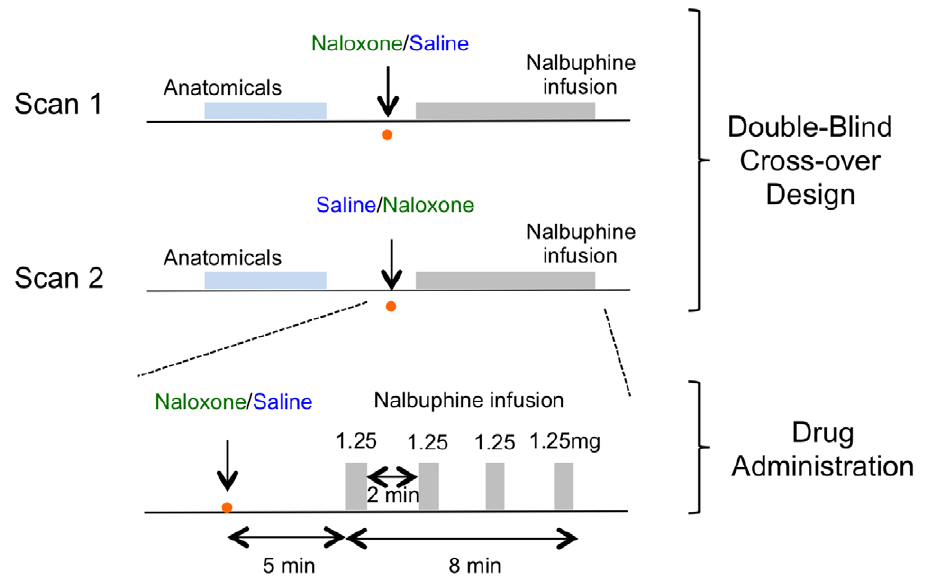
Figure 1. Drug administration protocol. After the initial anatomical scans were obtained, either naloxone or saline was infused for Scan 1; for Scan 2 the other drug was infused. Nalbuphine infusion was then started five minutes later. One quarter of the nalbuphine dose was administered every other minute until the full amount was delivered by eight minutes.